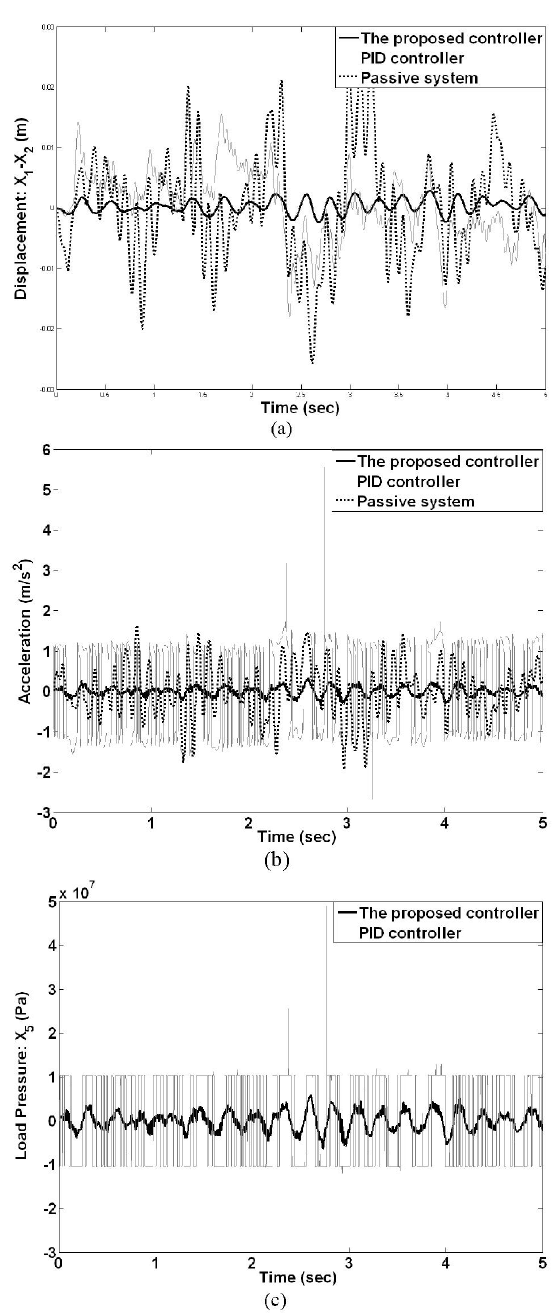
Figure 11. The system with varied parameters is imposed by bump road profile depicted in Fig. 3. (a) Suspension travel for the pro- posed controller, PID and passive suspension system, (b) Vertical vehicle body acceleration for the proposed controller, PID and pas- sive suspension system, (c) Load pressure for the proposed con- troller and PID Results have been achieved for bump and random input profiles along with using nominal and varied pa- rameters values. As the results demonstrate, further im- provement have been accomplished through suspension